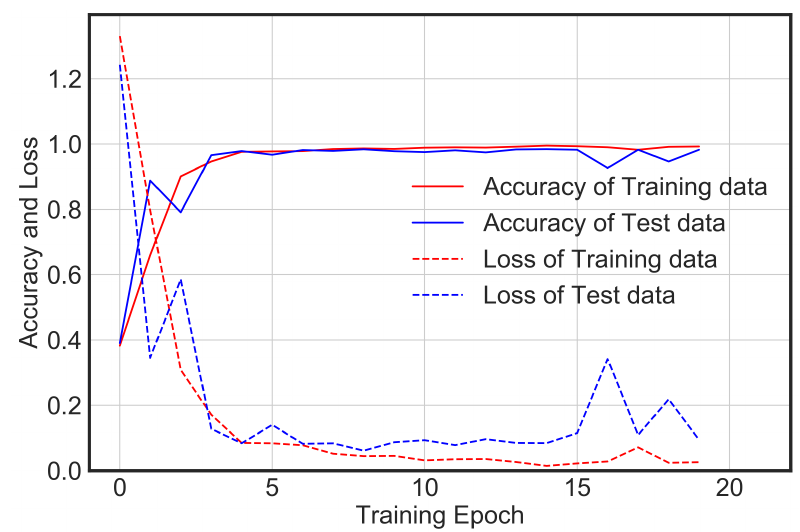
Figure 12. VGG16 Net model accuracy and loss for augmented